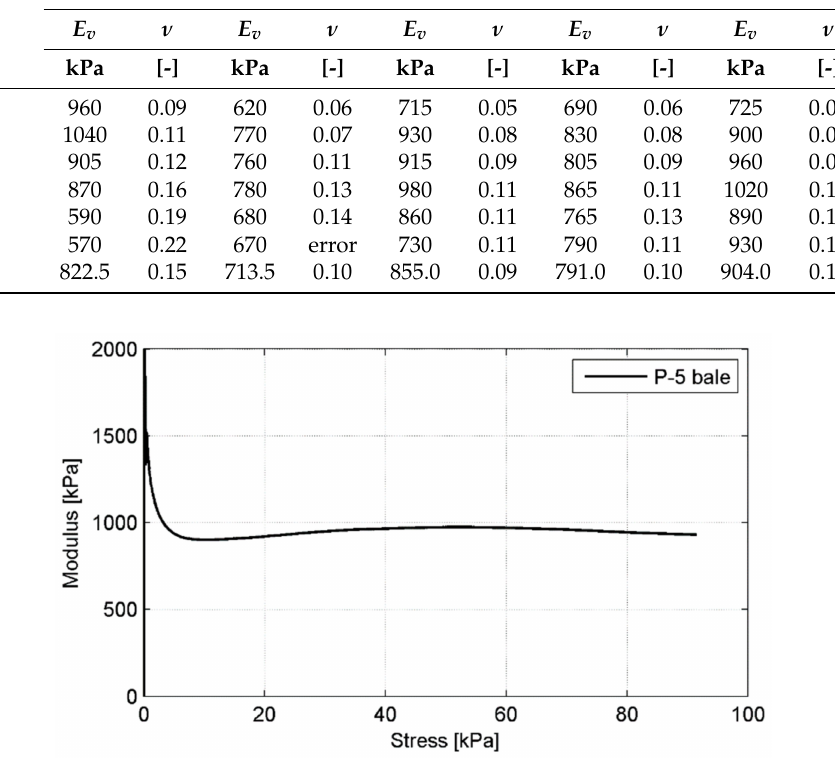
Load Range (Cycle)